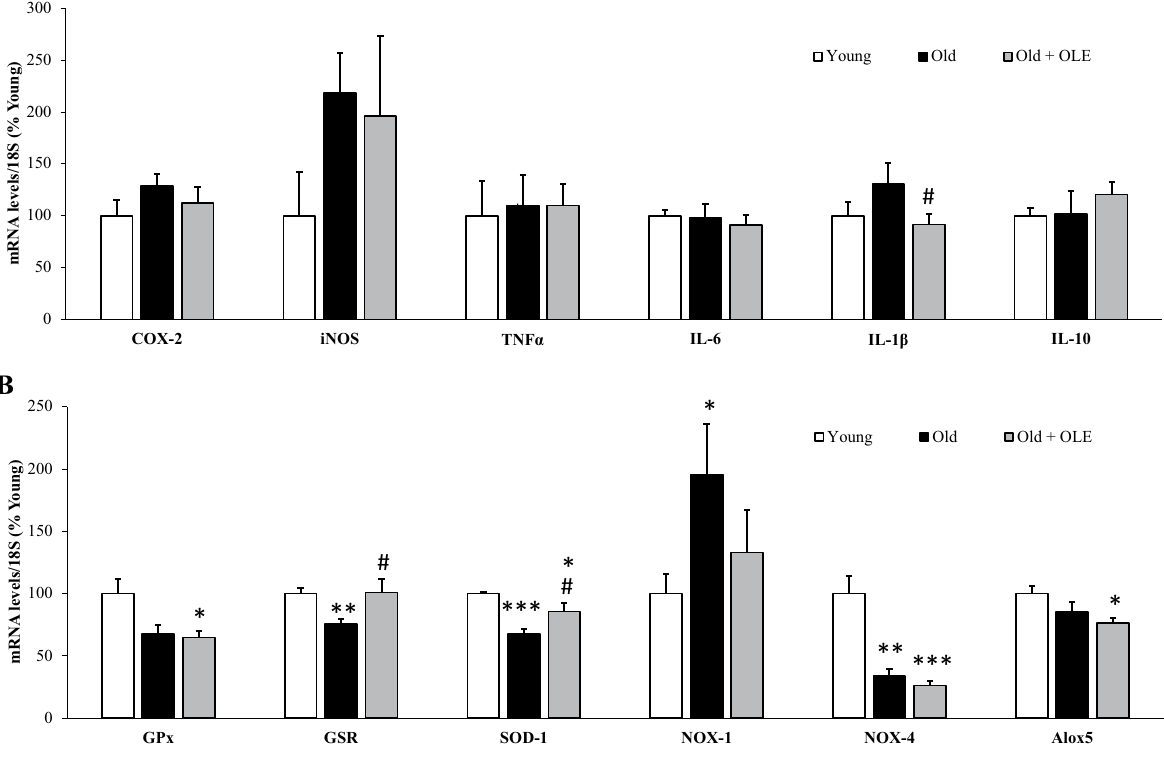
Figure 3. Effects of aging and a 21-day treatment with the OLE on mRNA concentrations of ciclooxigenase-2, inducible Nitric Oxide Synthase, Tumor Necrosis Factor α, Interleukin 6, Interleukin 1β and Interleukin 10 ( A ) and Glutathione Peroxidase, Glutathione Reductase, Super Oxide Dismutase 1, NADPH oxidase 1 and 4, and Lipoxygenase ( B ) in rat hearts. Values are represented as mean ± SEM.* p < 0.05 vs. Young; ** p < 0.01 vs. Young; *** p < 0.001 vs. Young; # p < 0.05 vs.